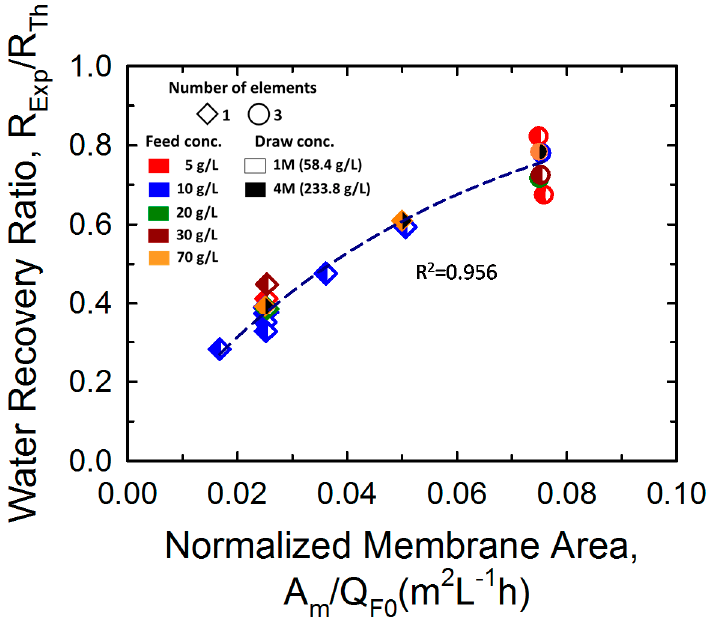
Figure 8. Water recovery ratio ( R Exp / R Th ) depending on normalized membrane area ( A m /Q F0 ). The shape of the symbol indicates the number of FO elements—one (diamond) and three (circle). The left and right colors in the symbols represent the feed and draw concentrations, respectively. The applied feed (5, 10, and 15 LPM) and draw flow (5, 10, and 15 LPM) rates are not expressed individually for simplicity. The fitting regression equation is R Exp / R Th = 1 − e − 18.74 × A m / Q 0 (R 2 =